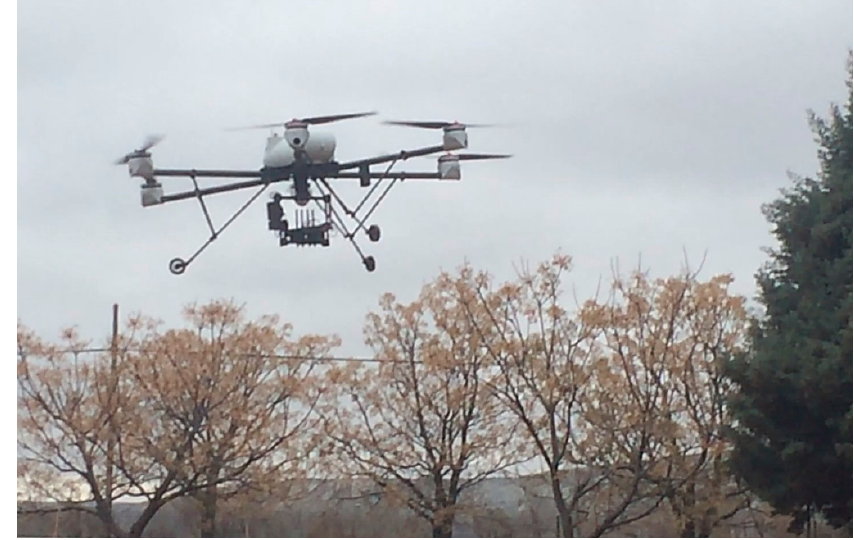
Figure 10. Hexrotor (AirRobot AR-200) carrying a vision camera for remote detection of weeds.